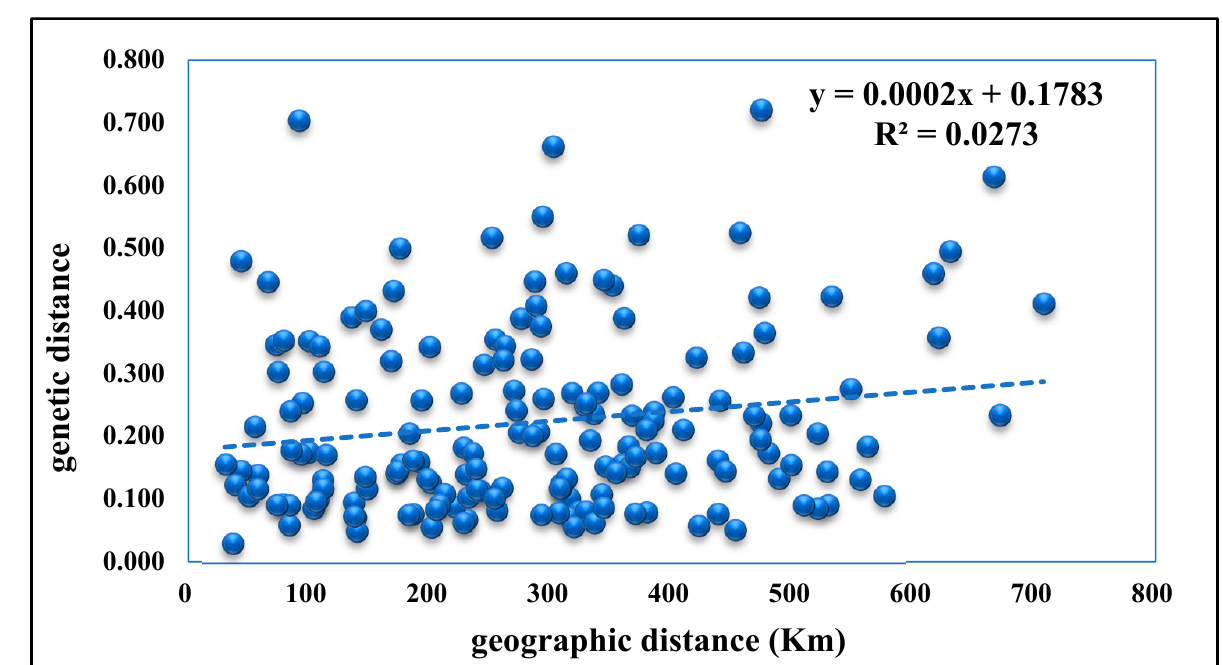
Figure 2. Mantel test between the genetic distances (GDs) and geographical distance of 19 ancient P. orientalis populations. Bayesian analysis of the population structure yielded the highest ∆ K value